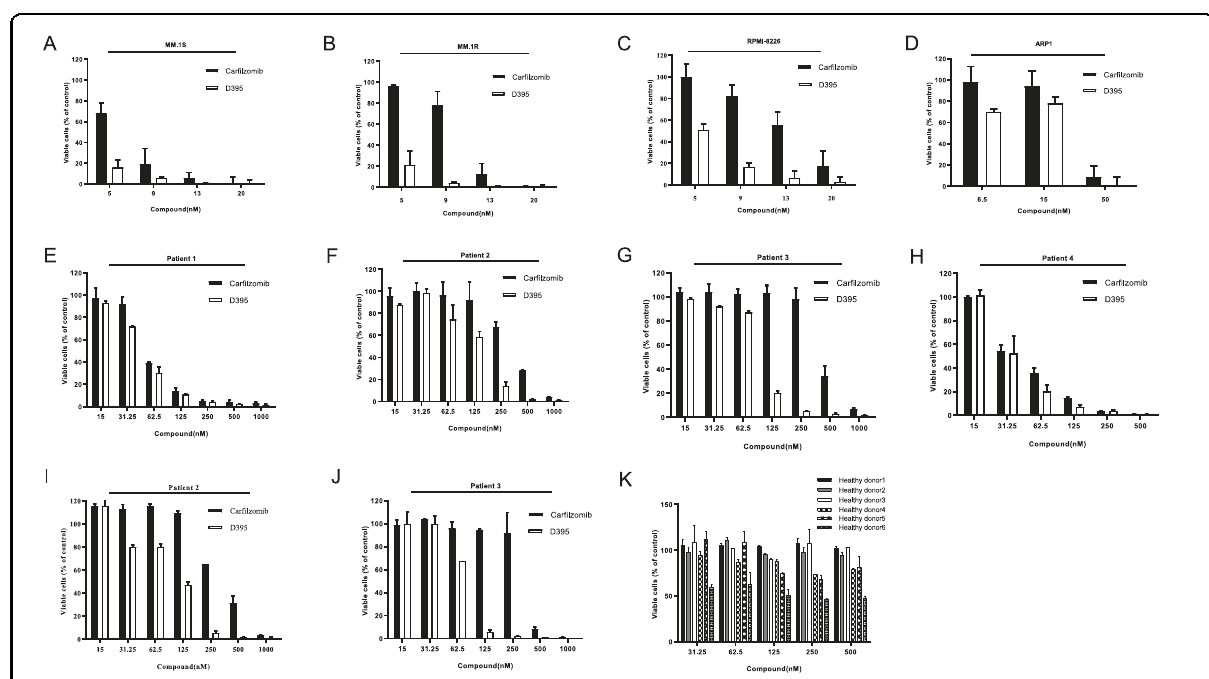
Fig. 2 The cytotoxicity of D395 in MM cells. Four MM cell lines, MM.1S ( A ), MM.1R ( B ), RPMI-8226 ( C ) and ARP1 ( D ), were exposed to D395 or car fi lzomib for 24 h followed by the cell cytotoxicity test. The CD138 + population isolated from three newly diagnosed MM patients ( E – G ) and one relapsed MM patient ( H ) were treated with different concentrations of D395 or car fi lzomib for 24 h for the cell cytotoxicity test. I , J Patient 2- and patient 3-derived CD138 + populations were treated with various concentrations of D395 or car fi lzomib for 36 h followed by CCK-8 test. K PBMCs from six healthy donors were treated with D395 or car fi lzomib to evaluate cell cytotoxicity in normal